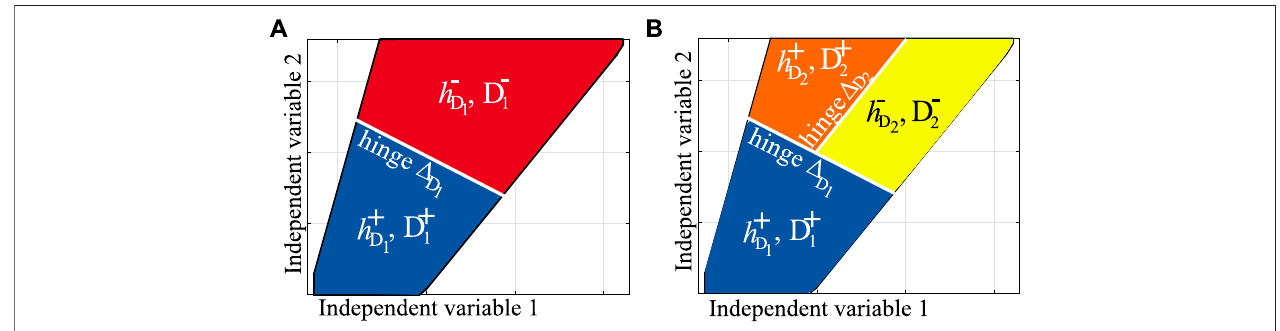
FIGURE 4 | Example of step 6 in AutoMoG3D for an arbitrary component with two independent variables. On the left (A) the measured data are approximated by two hyperplanes. The hyperplane h + D approximates the data subset D + 1 and the hyperplane h − D 1 Thus, on the right (B) , the hyperplane h −